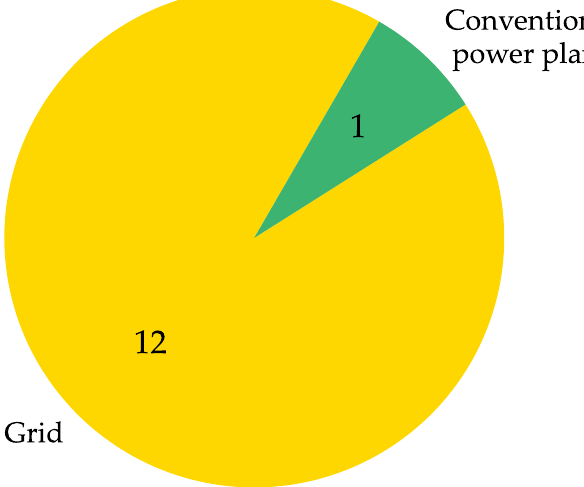
Figure 13. Number of projects per non-RES electricity source.